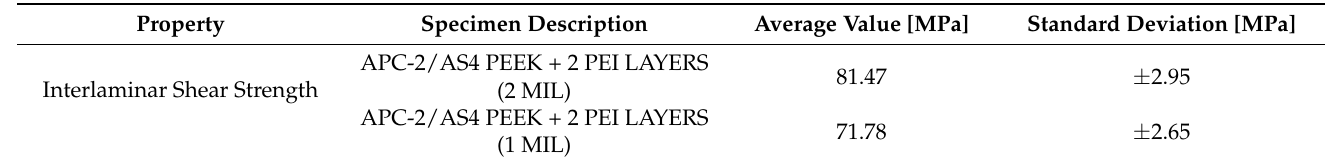
Table 1. Table 1. ILSS results for both material versions tested.